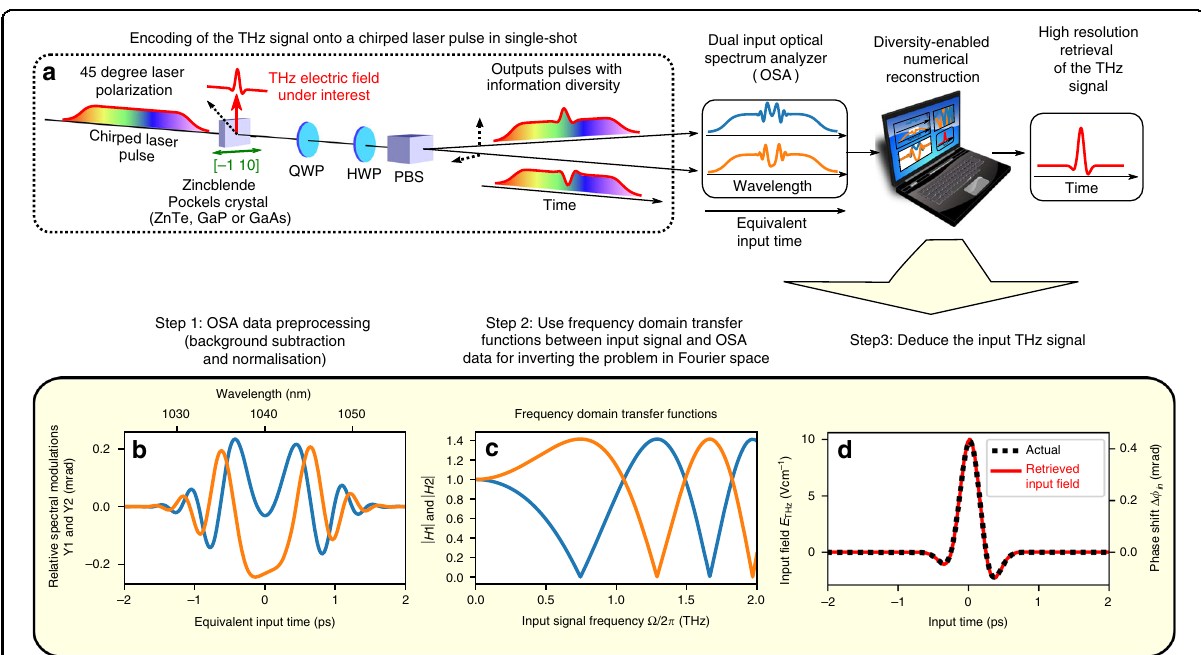
Fig. 2 Principle of Phase Diversity Electro-optic Sampling, DEOS, for single-shot recording of THz electric fi elds. a Experimental design: The input THz fi eld evolution modulates a chirped laser pulse, and the DEOS design provides two outputs that contain different information. Using this two-output design (see Table 1 for details), the recorded information is suf fi cient for removing the problem, i.e., retrieving the input signal with high resolution. b − d Main steps of our reconstruction method (numerical simulation). b Raw electro-optic sampling (EO) signals (optical spectra after background subtraction and normalization). c Transfer functions H 1 and H 2 corresponding to the two polarization outputs showing the phase diversity operation. d Input signal retrieved from the recorded OSA signals [displayed in ( b )] and the transfer functions H 1,2 ( Ω ) [displayed in ( c )], using the MRC algorithm (Eq. 10). Laser parameters close to those of the European XFEL experiment presented hereafter (1040 nm wavelength and 40 nm FWHM bandwidth, τ w = 5 ps